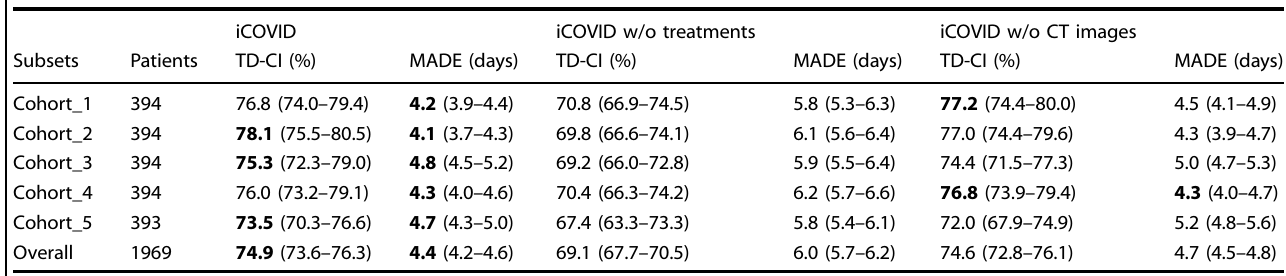
Table 1. Fivefold cross-validation results: impact of treatments and CT images.